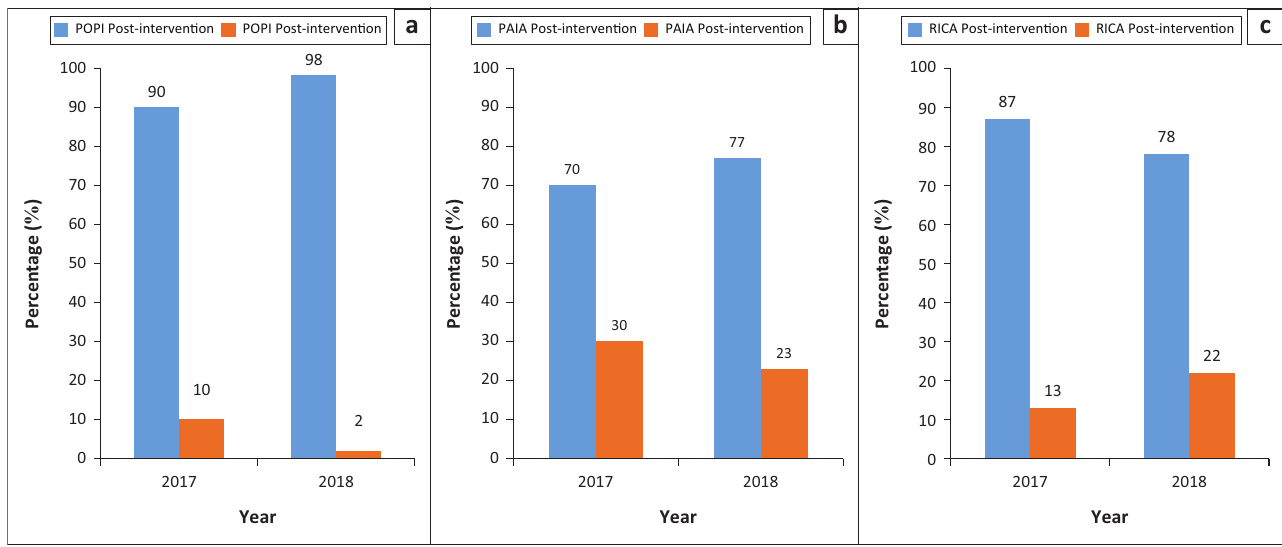
FIGURE 3: Post-intervention responses to acronyms Protection of Personal Information, Promotion of Access to Information Act and Regulation of Interception of Communication Act for the years 2017 and